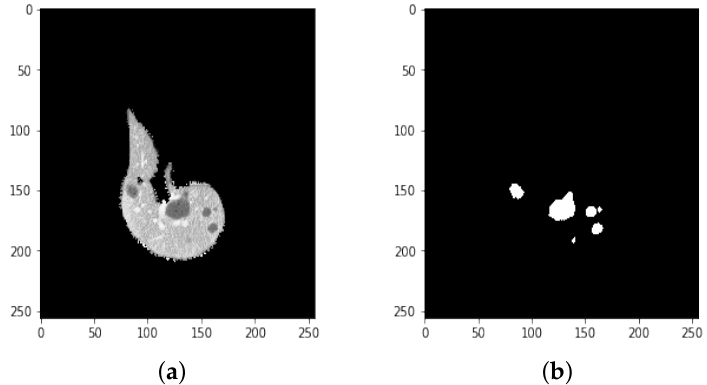
Figure 12. ( a ) A ground truth tumor image and ( b ) the resulting tumor